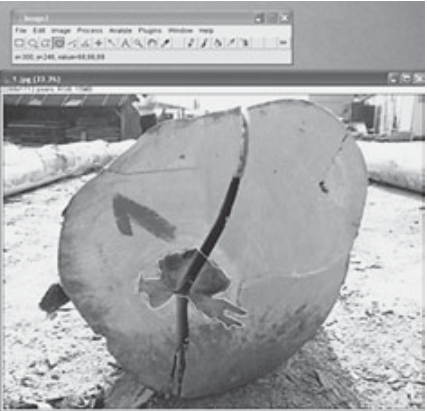
Figure 2 Analysis of false heartwood by software product